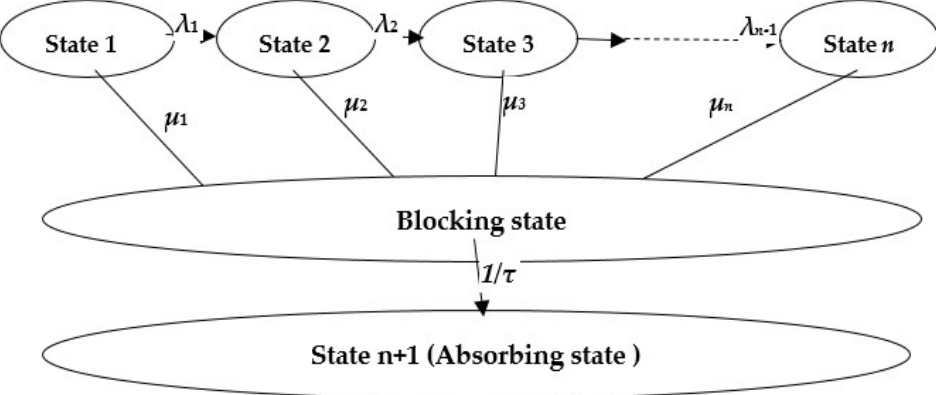
Figure 4. Schematic representation of single absorbing state process with the blocking state. The initial distribution (at time t = 0) of patients in each state is represented by vector s 0 and is defined as follows: